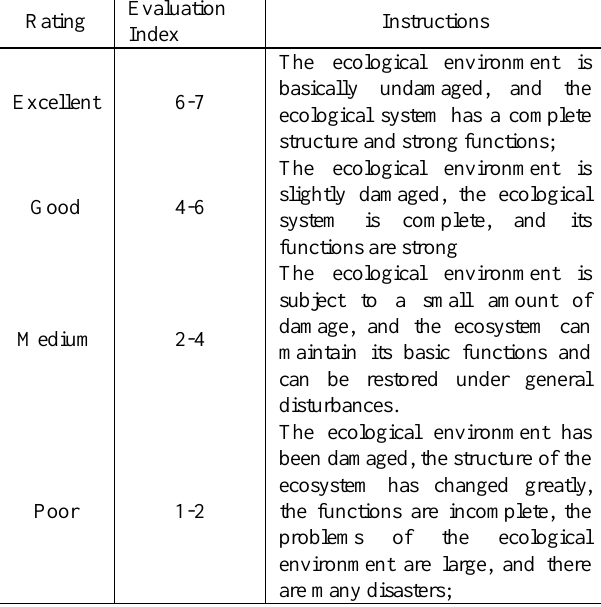
Table 4. Classification Table of Ecological Environment Safety